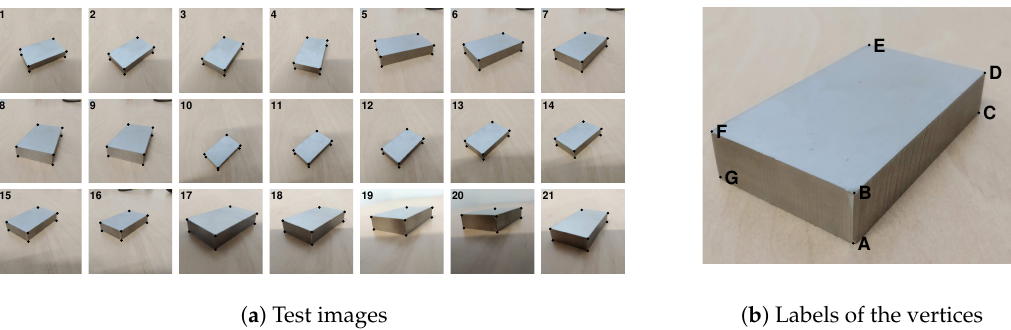
Figure 1. The 21 images (Photo Credits: Copyright 2020 Baker Hughes Company. All rights reserved. ) of the metal block used for testing the DLT, Bouguet’s method (BOU), and weighted DLR (wDLT) algorithms. The control points (black dots) are manually selected on the images. They correspond to the seven visible vertices of the parallelepiped. The reprojection error, using DLT to calibrate the camera, is 2.5 ± 1.3